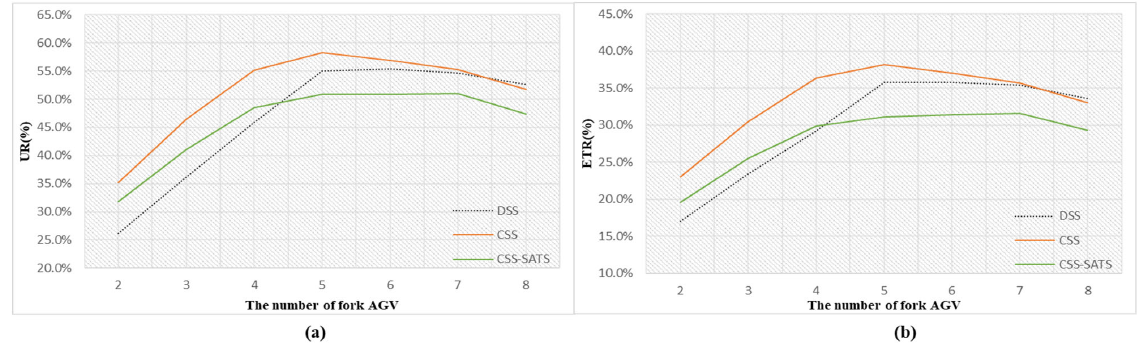
Fig. 11. The performance in UR (a) and ETR (b) in experiment B